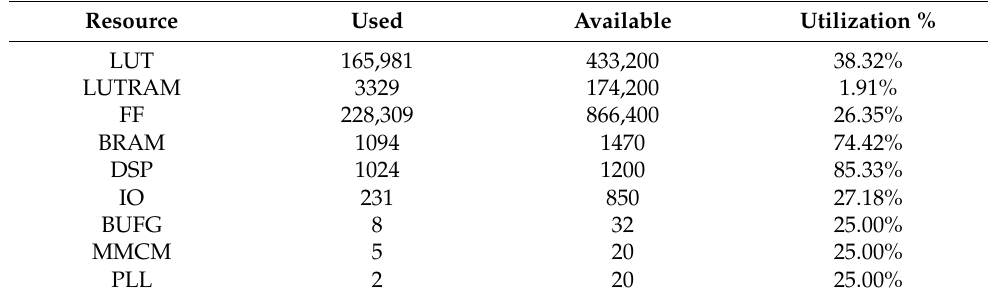
Table 1. FPGA resource